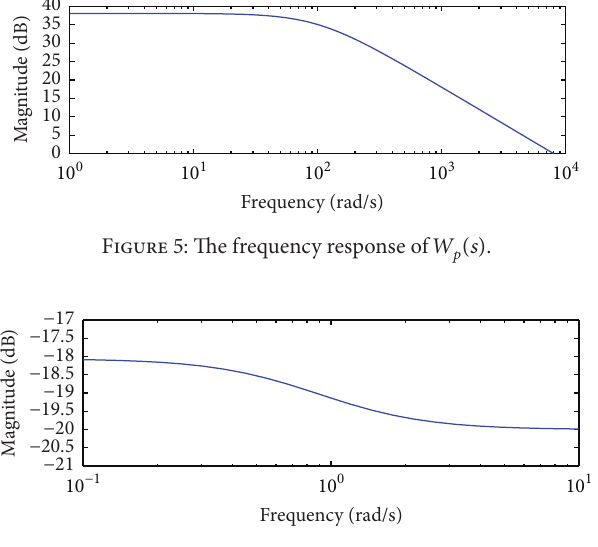
Figure 6: The frequency response of 𝑊 𝑡 (𝑠) .